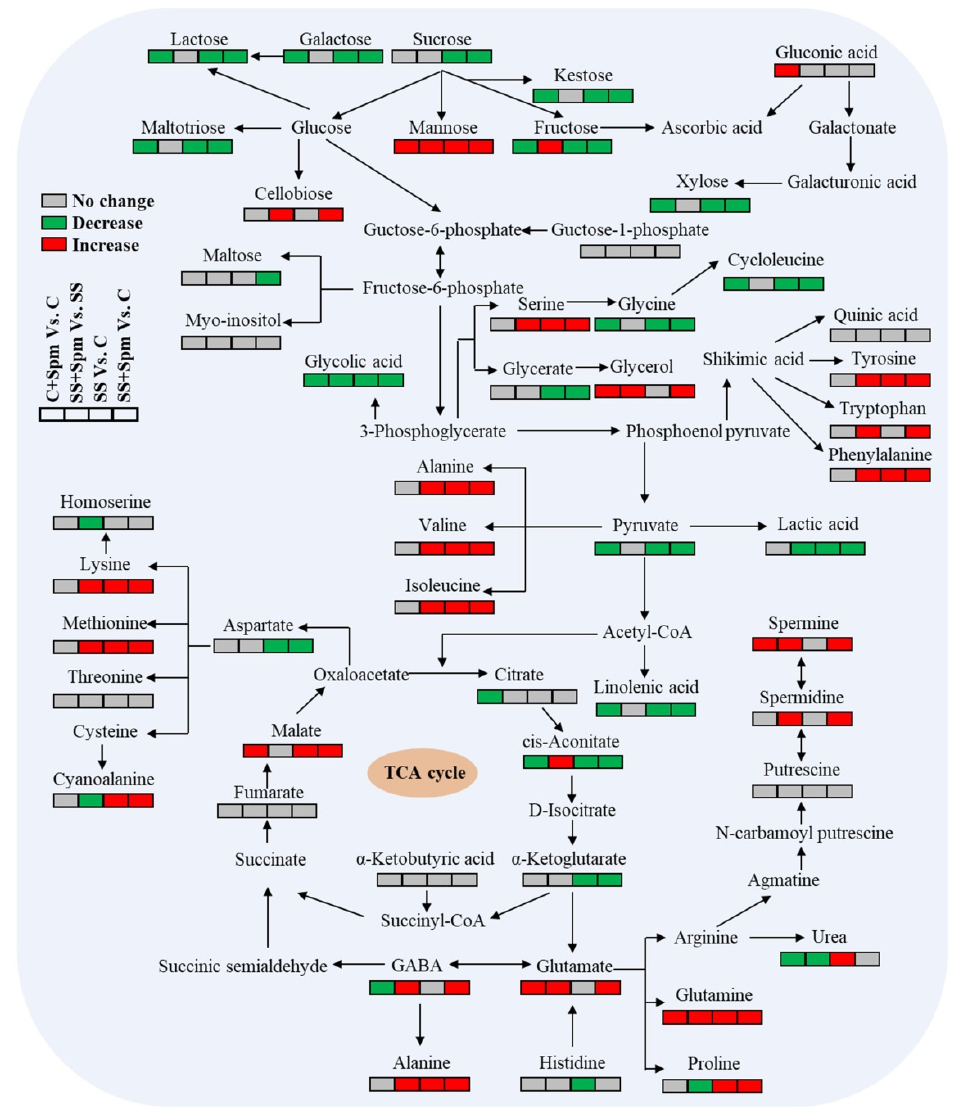
Figure 10. Pathway enrichment analysis of identified metabolites in leaves of creeping bentgrass in response to exogenous application of spermine under normal condition and salt stress.